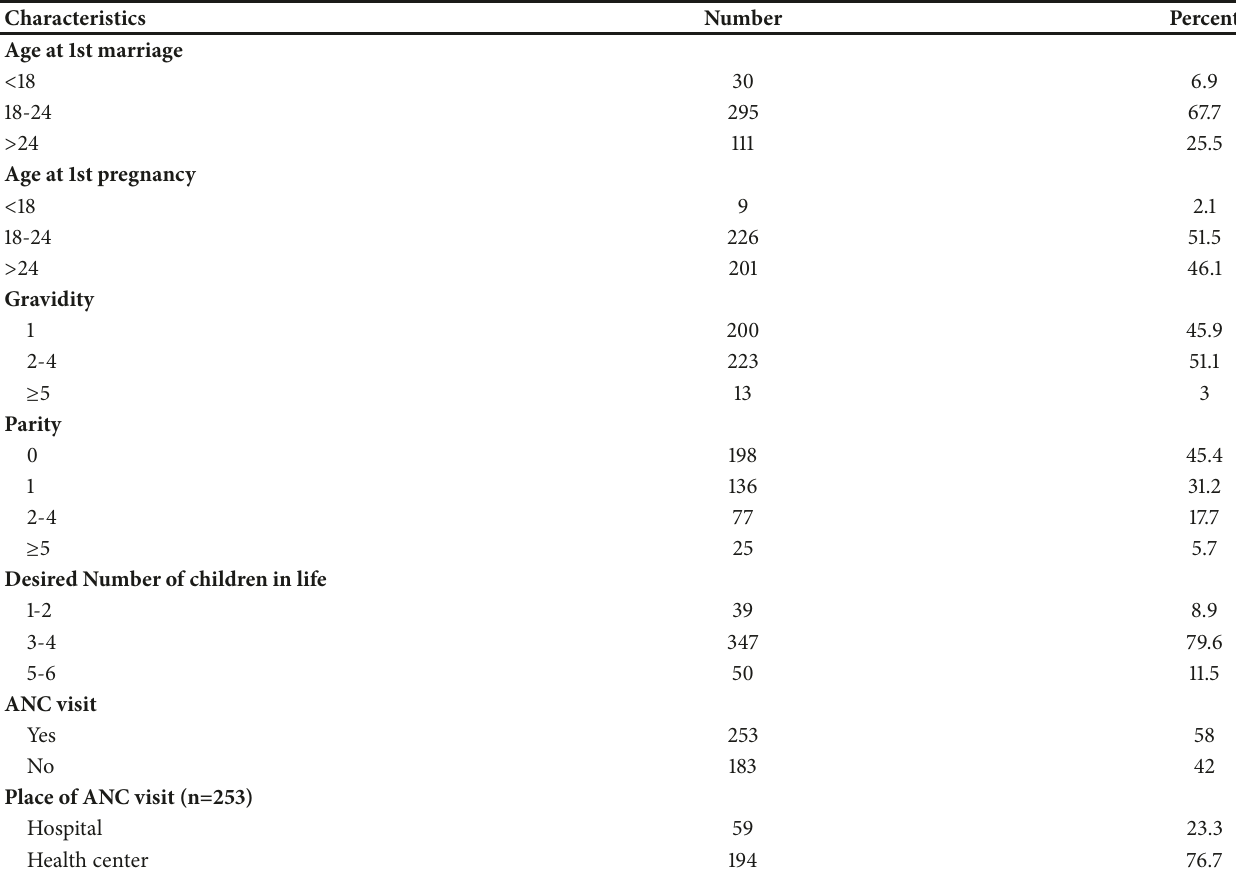
Table 2: Obstetric characteristics of pregnant women in Debremarkos town,